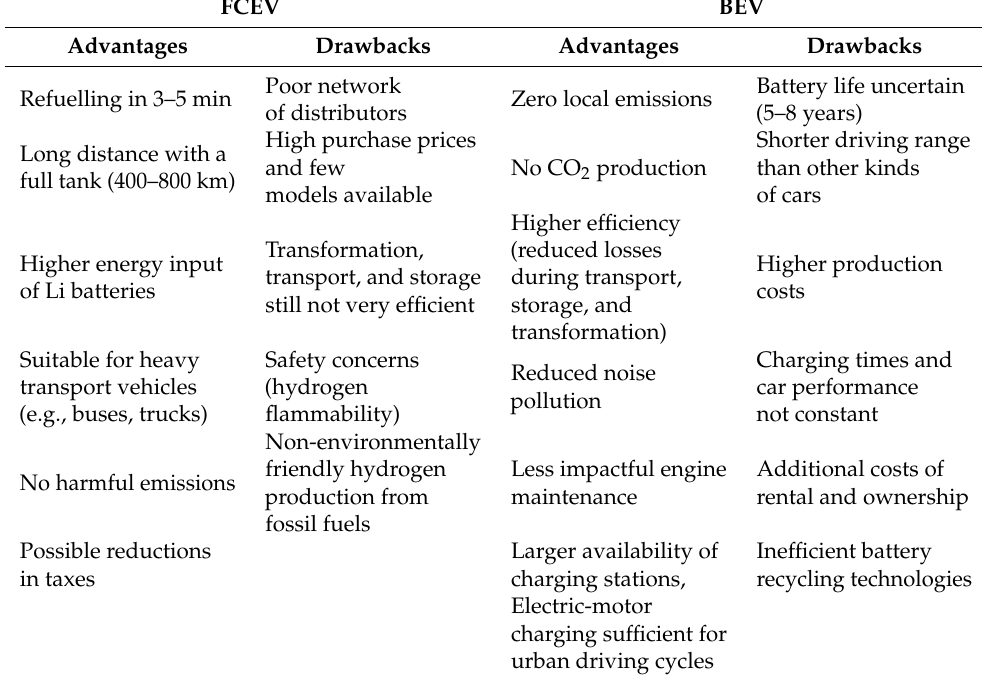
Table 2. Advantages and drawbacks of FCEV and